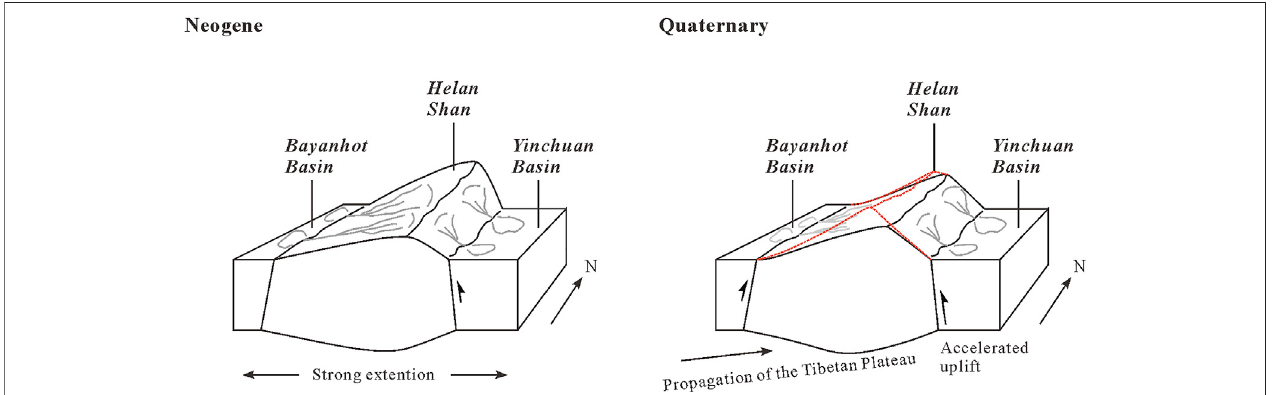
FIGURE9| TectonictransformationmodeloftheHelanShan.Theorange-dashedlinesindicatethefuturetopography.TheembryooftheHelanShanformedviaa strong extension of the Ordos Block in the late Neogene, which appeared as a tilting tectonic model in the southwest direction (Liu et al., 2010). In the early Quaternary, expansion of the Tibetan Plateau affected the Helan Shan; the uplift rate of its southern end increased and the pattern of tectonic uplift changed to a northwest tilt. The Helan Shan will likely form topography characterized by a high in the south and a low in the north in the future.